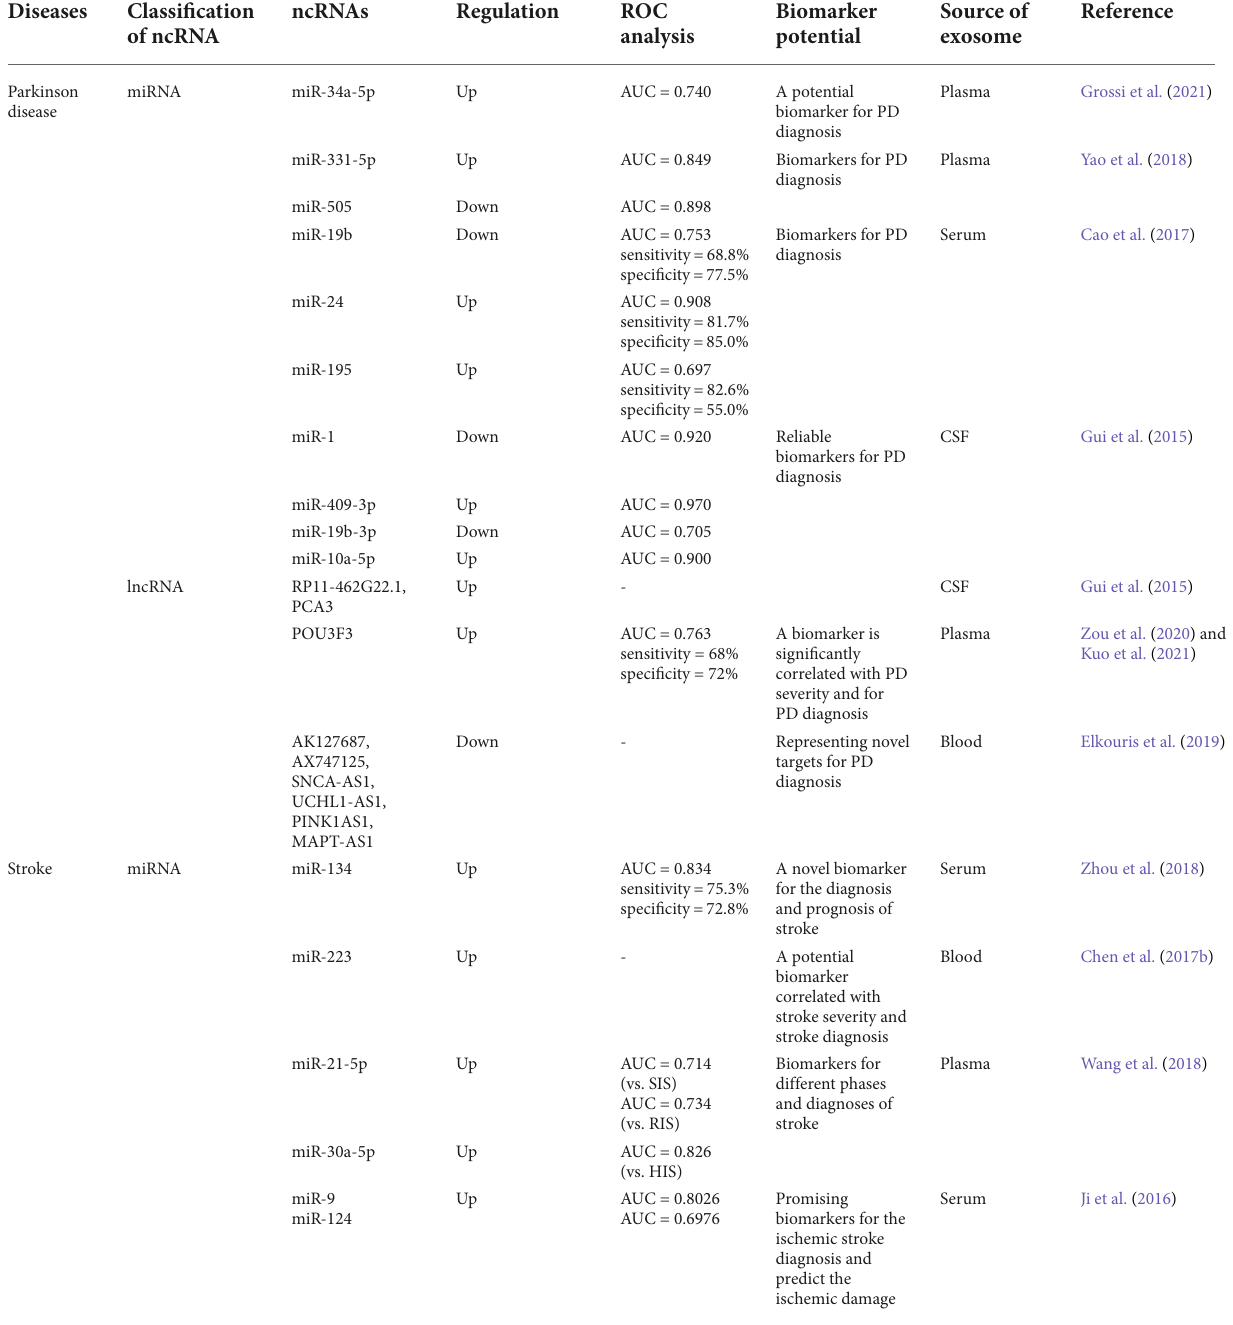
TABLE 5 The biomarker potential of exosomal ncRNAs in Parkinson’s diseases and stroke.